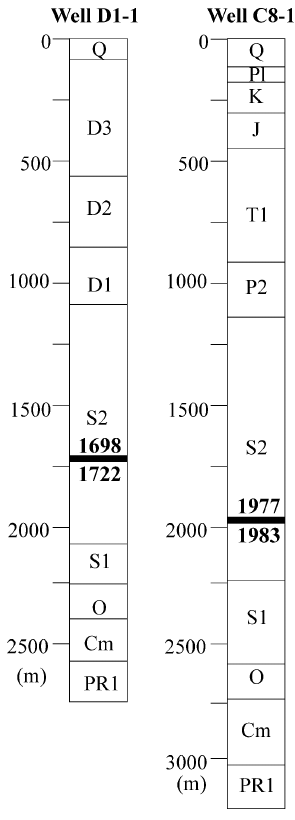
Fig. 2. Geological sections of wells D1-1 and C8-1 (see Fig. 1 for locations). Dolerite sills are marked by a thick